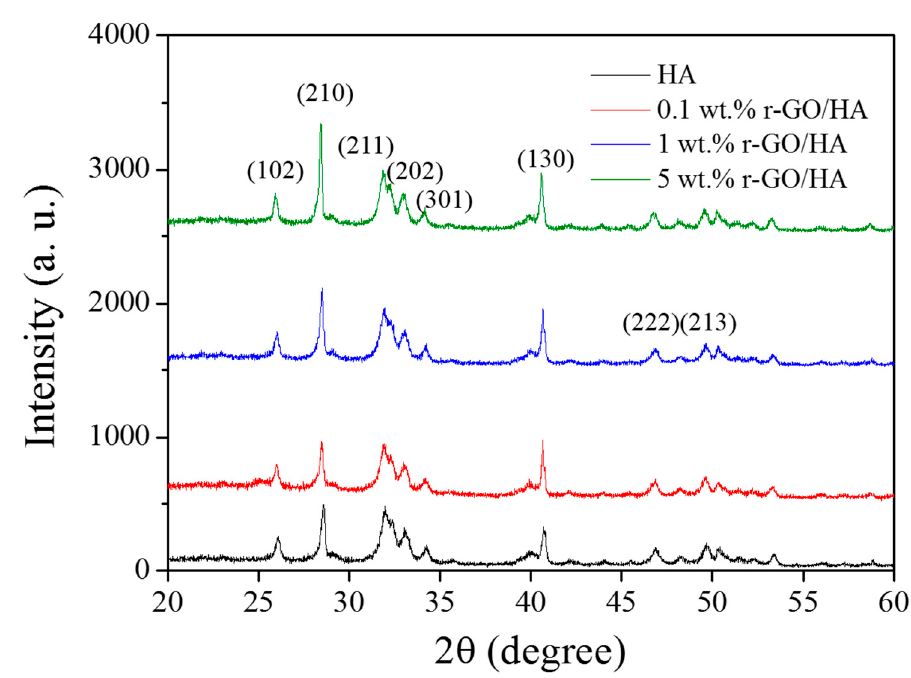
Figure 3. X-ray diffraction (XRD) of sintered HA and r-GO/HA NCPs with different concentra- of r-GO. tions of r-GO.